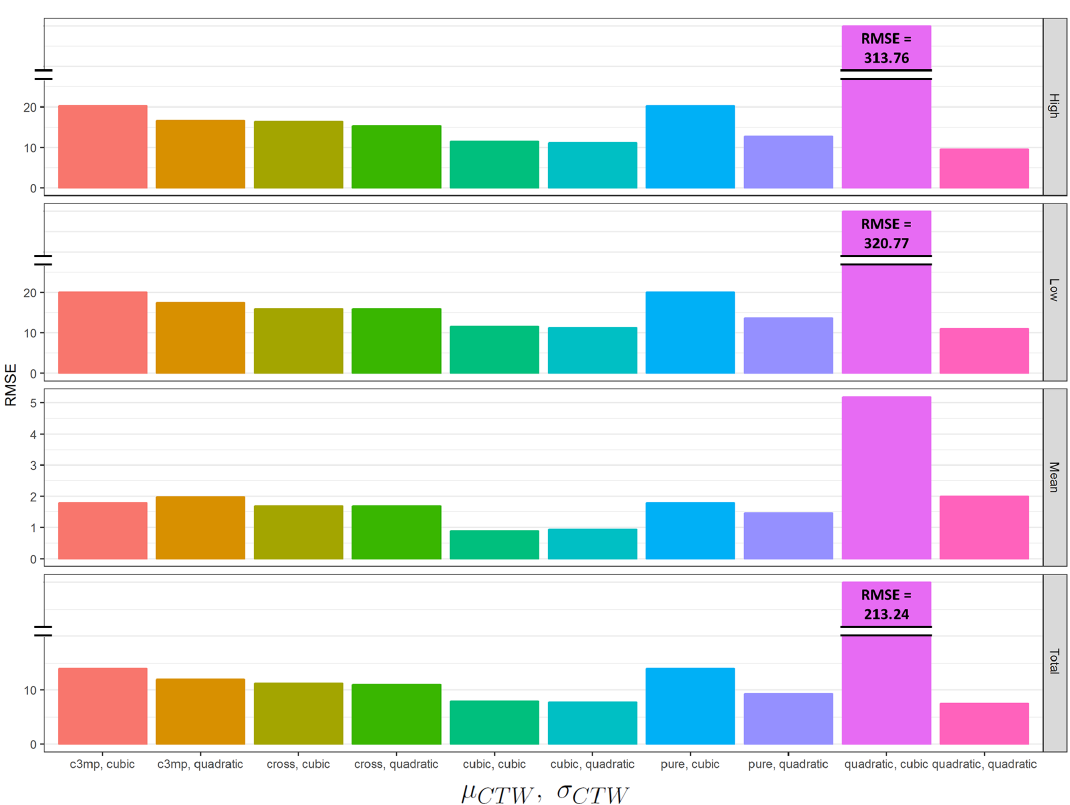
Figure A1. Comparison of leave-one-out cross-validation average RMSE measures for each functional form across all ensembles. Each functional form is labeled as µ CTW , σ CTW . Note the broken scales to capture the performance of quadratic µ CTW , cubic σ CTW . 2 (cid:49)C + a 2 + a + a 12 ((cid:49)T ) 13 (cid:49)T ((cid:49)W) 14 (cid:49)T ((cid:49)C)